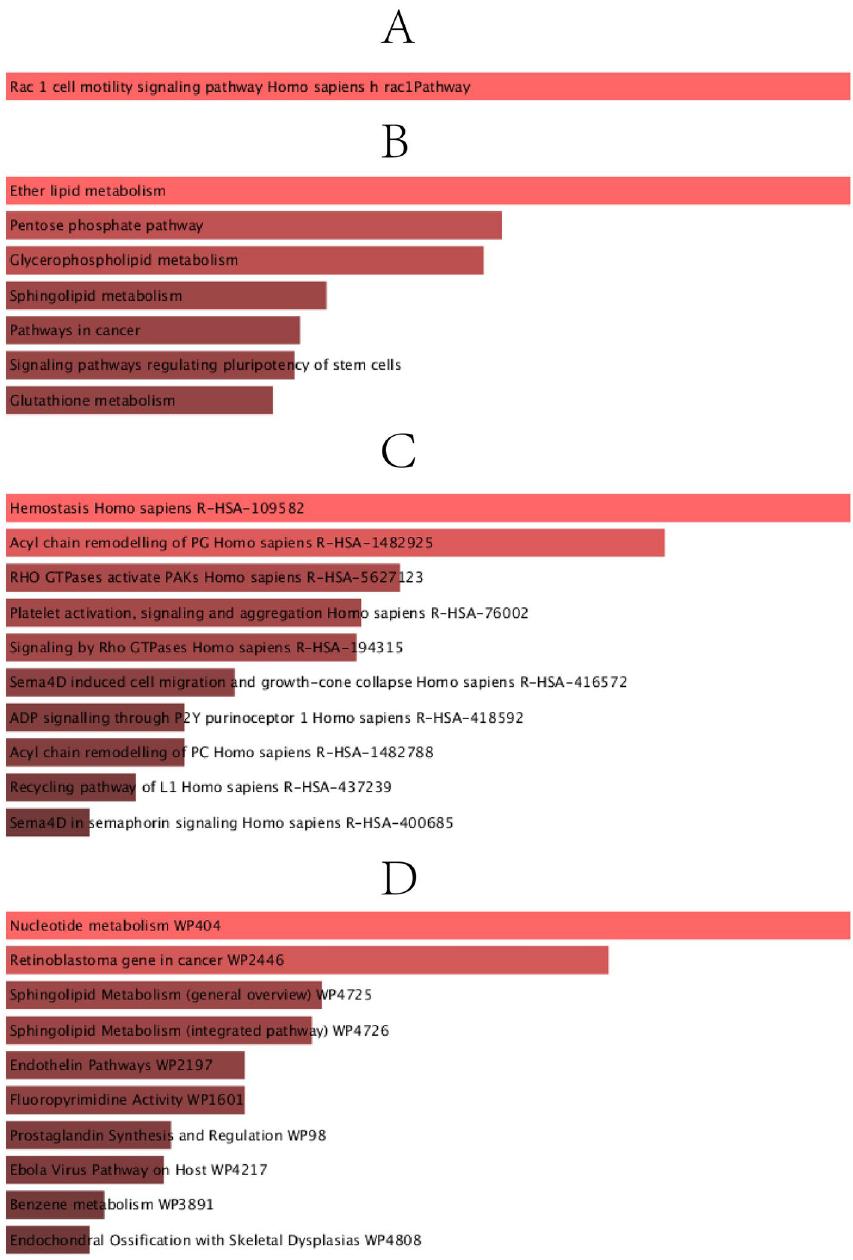
pathway, ( C ) Reactome pathway, and ( D ) Wiki